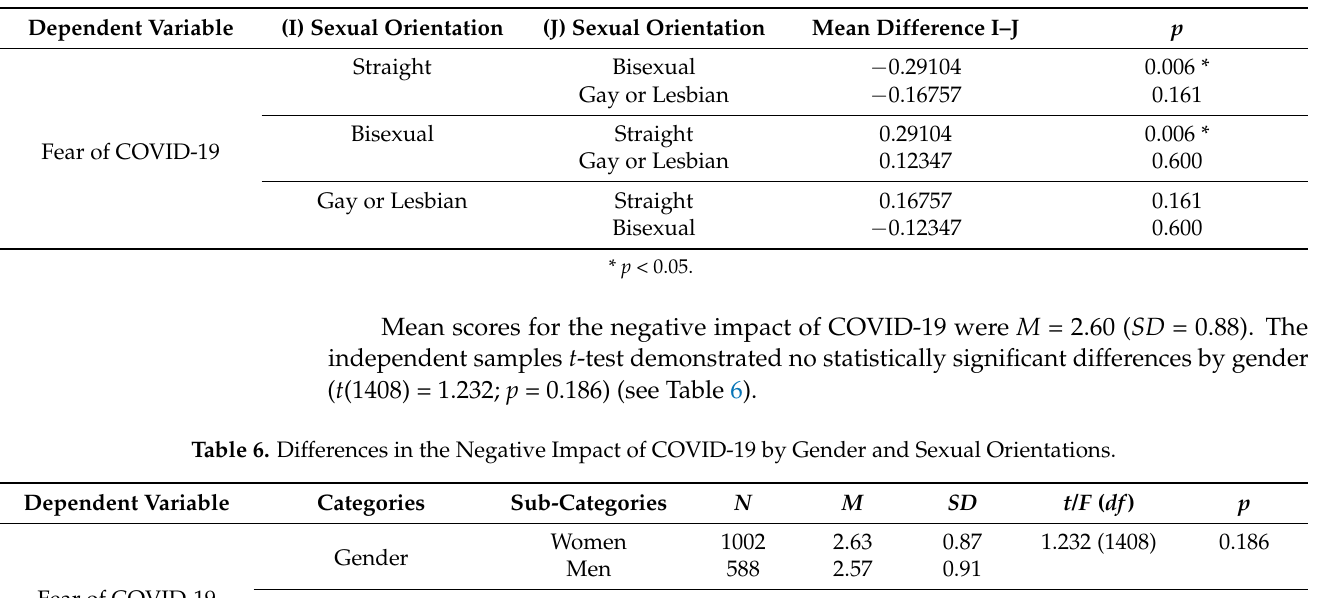
Table 5. Results for Fear of COVID-19 by comparison groups (Sexual Orientation).